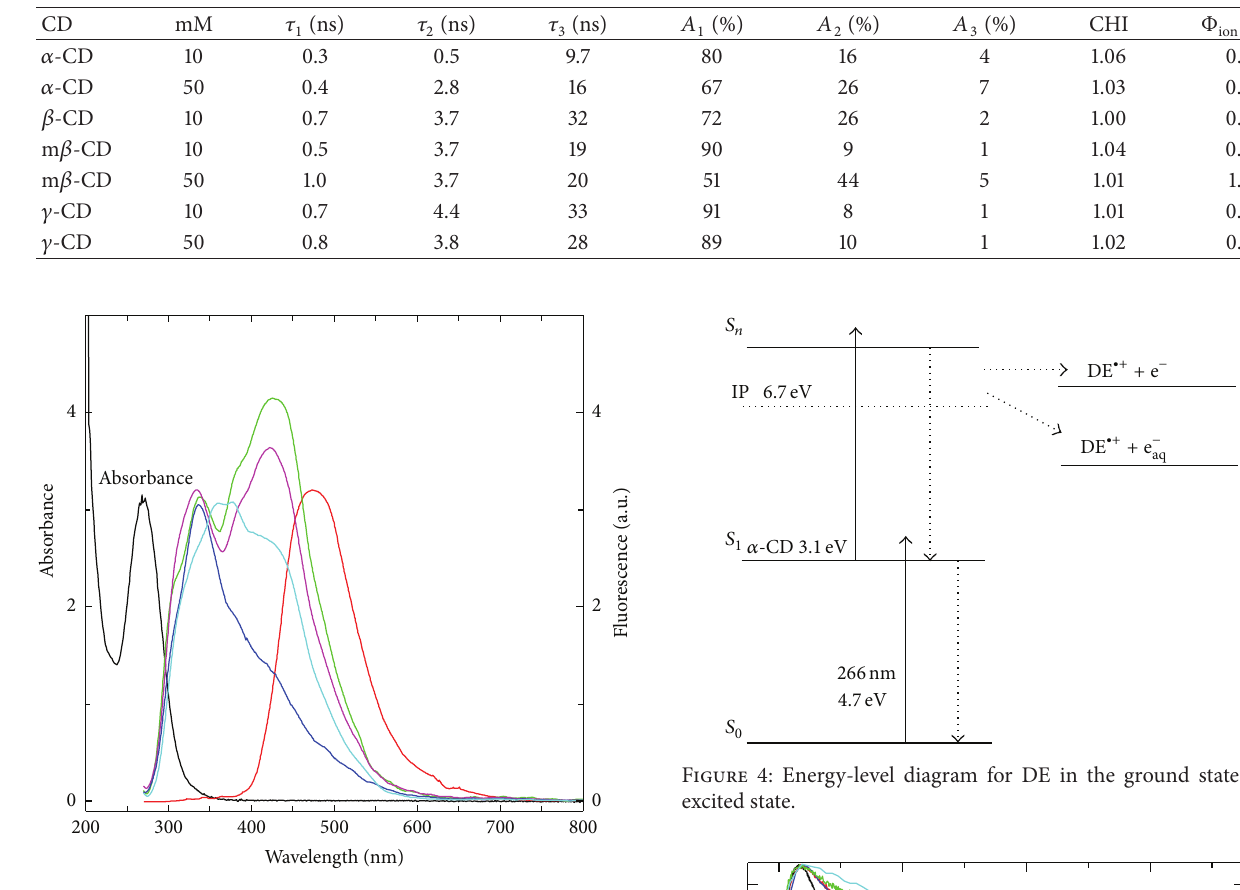
Table 1: Ionization quantum yields and fluorescence lifetimes of DE (6.1 × 10 −5 M) in the presence of 𝛼 -CD (10 −3 or 5 × 10 −3 M), 𝛽 -CD